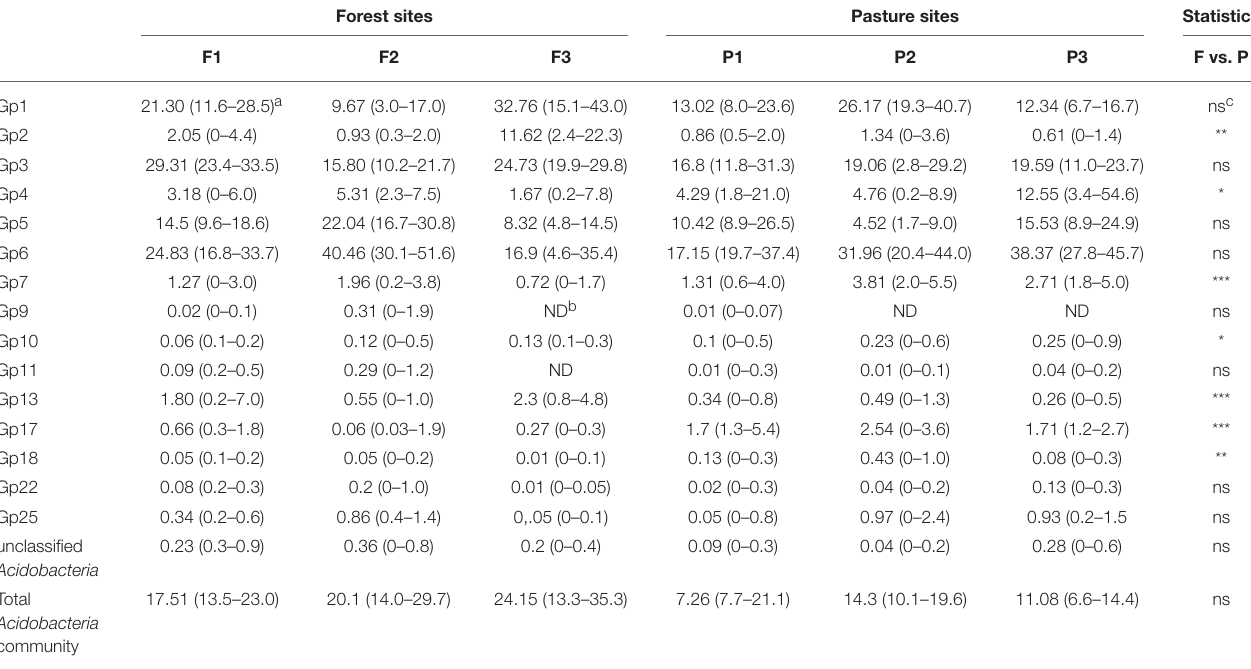
TABLE 1 | Percentage of Acidobacteria subgroups relative to all Acidobacteria and of these to all Bacteria in forest and pasture